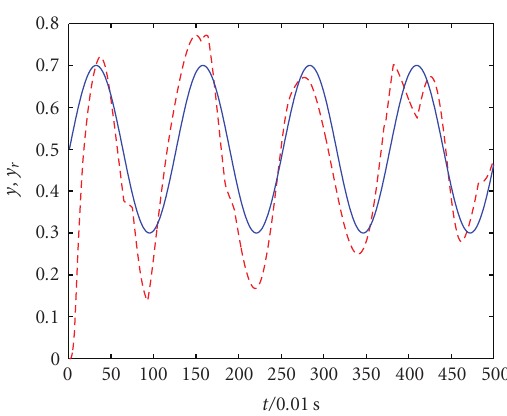
Figure 4.6. Output in periodic-signal